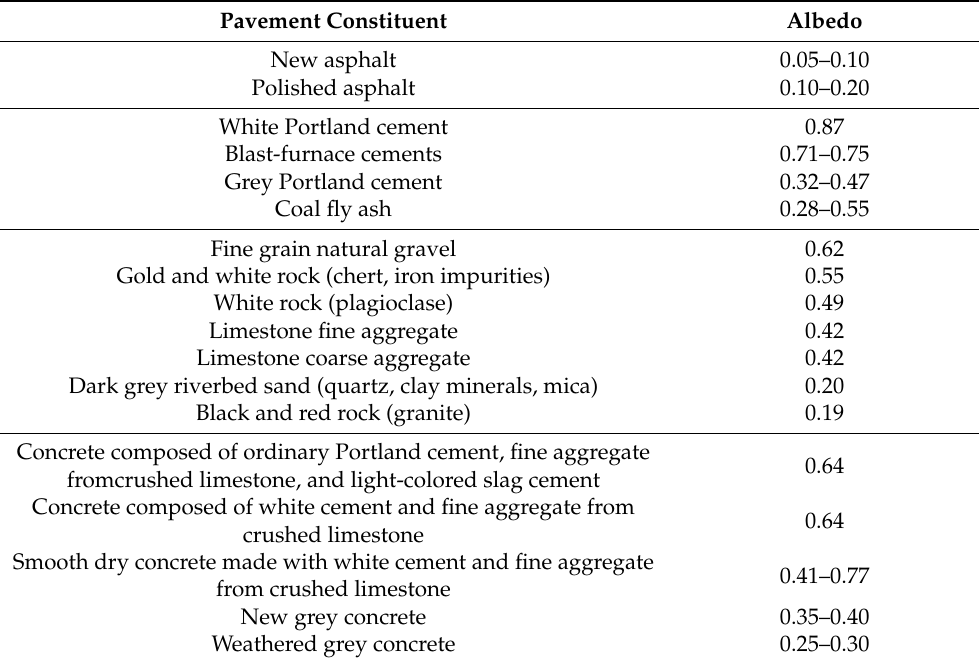
Table 1. Albedo of typical pavement materials and concrete